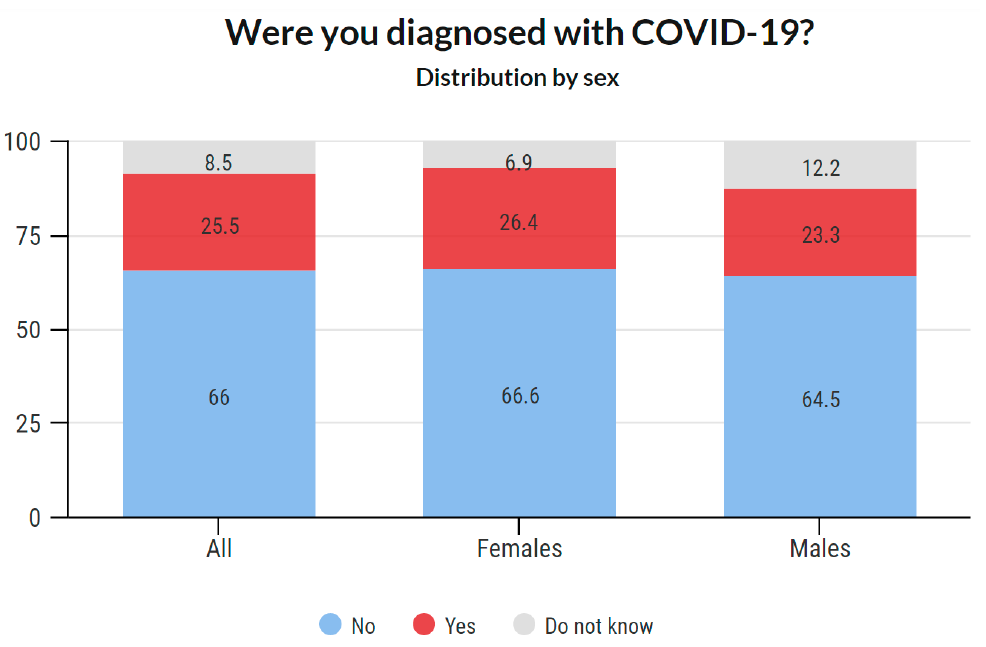
Figure 5. COVID-19 positivity, distribution by sex.